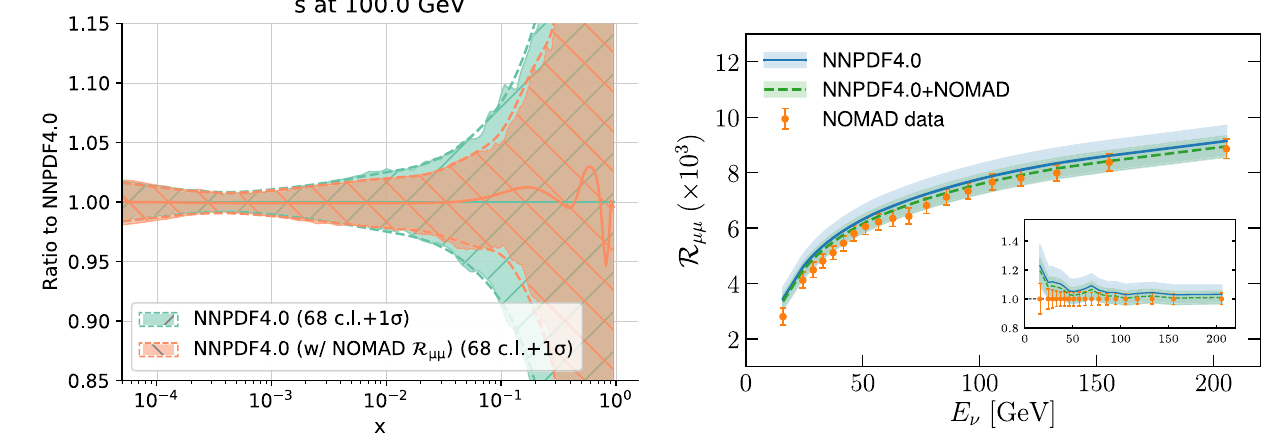
Fig. 43 (Left) Comparison between the baseline and PDFs in which the NOMAD neutrino DIS data are included by reweighting. The strange PDF is shown at Q = 100 GeV. (Right) The same compar-